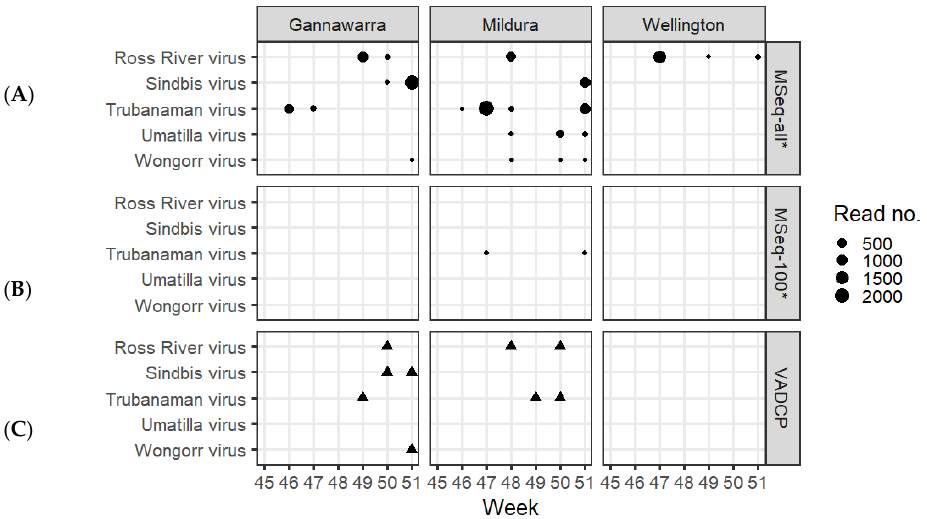
Figure 5. Arbovirus detections in traps from Gannawarra, Mildura and Wellington over seven weeks (45–51) in 2016. Detections based on metatranscriptomic sequencing (MSeq) are shown in ( A ) when using all subsamples and ( B ) when using only the 100-mosquito subsamples. The size of the dots is proportional to the number of reads contributing to each arbovirus detection. ( C ) shows the arboviruses detected via cell culture during the initial screening of mosquitoes subsampled from each trap by the Victorian Arbovirus Disease Control Program (VADCP) during the 2016/17 season. Each triangle represents one cell culture detection of each arbovirus. The * indicates that ( A , B ) represent a separate mosquito subsample to ( C ).